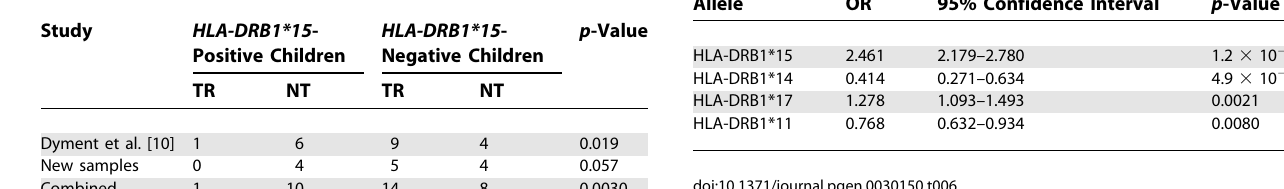
Table 5. Transmission of HLA-DRB1*10 from non -HLA-DRB1*15- Bearing Parents to Offspring Stratified by the Presence or Absence of HLA-DRB1*15